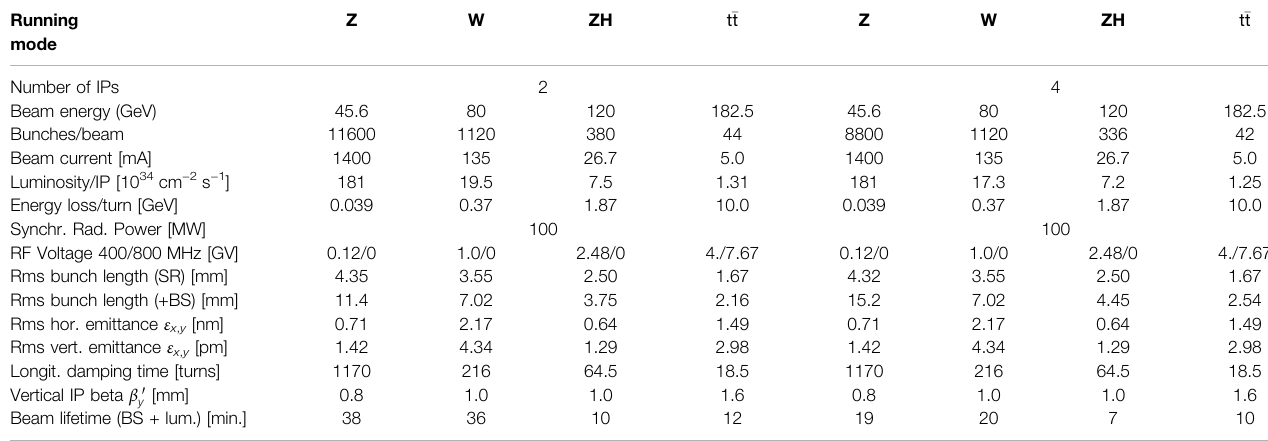
TABLE 1| PreliminarykeyparametersofFCC-ee[20],asevolvedfromtheCDRparameters, nowwithashorter circumference of91.2 km,andanewarcopticsforZandW running. Luminosity values are given per interaction point (IP), for scenarios with either 2 (left) or 4 IPs (right). Both the natural bunch lengths due to synchrotron radiation (SR)andtheircollisionvaluesincludingbeamstrahlung(BS)areshown.TheFCC-eeconsidersacombinationof400 MHzradiofrequencysystems(atthe fi rstthreeenergies, upto2× 2 GV)and 800 MHz (additional cavities fort (cid:1) toperation),with respective voltage strengths asindicated. Thebeam lifetime shown represents the combined effect of the luminosity-related radiative Bhabha scattering and beamstrahlung, the latter relevant only for ZH and t (cid:1) t running (beam energies of 120 and 182.5 GeV). Running mode